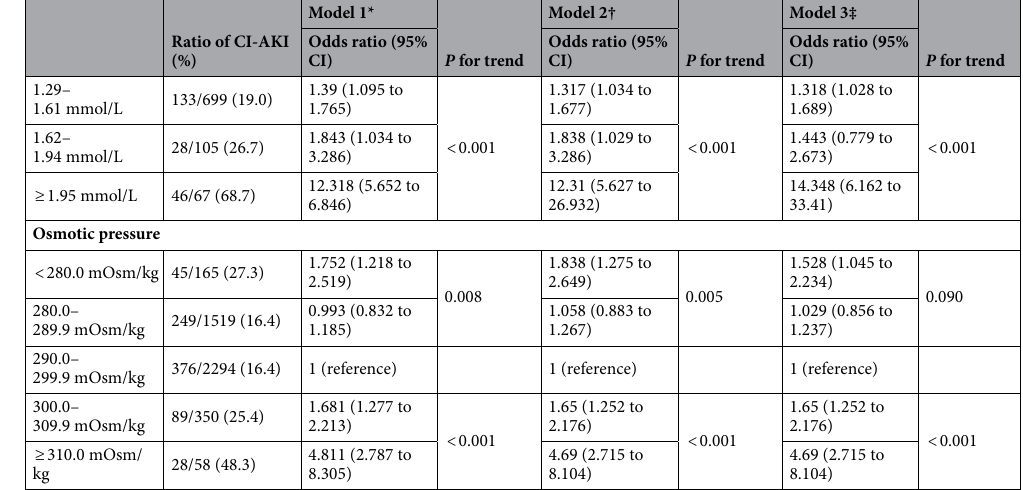
Table 2. Odds ratio (95% CI) of CI-AKI according to the categories of electrolytes and osmotic pressure. *Model 1: Adjusted for age (< 65 years or ≥ 65 years) and eGFR (< 30, 30–59, 60–89, or ≥ 90 mL/min/1.73m 2 ). † Model 2: Adjusted for age (< 65 years or ≥ 65 years) and eGFR (< 30, 30–59, 60–89, or ≥ 90 mL/min/1.73m 2 ), gender (male or female), diabetes (yes or no), hypertension (yes or no), current smoker (yes or no),current drinker (yes or no). ‡ Model 3: Additionlly adjusted for type of contrast agent (ioversol, iopamidol, or iodixanol), pre-admission of furosemide injection (yes or no), pre-admission of dopamine (yes or no).